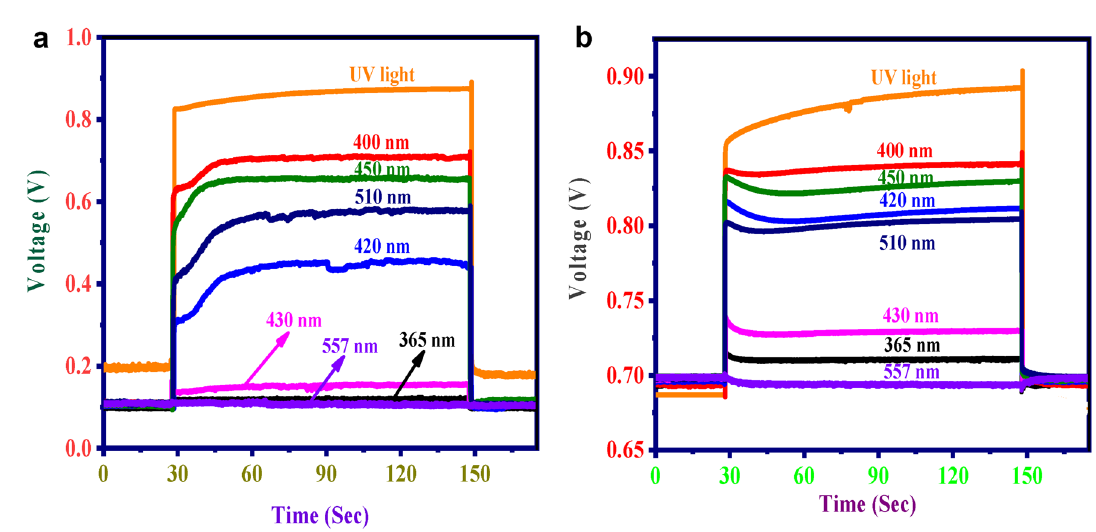
Figure 3. Selectivity analysis ( a ) perovskite alone, ( b ) NiS/ZnO with